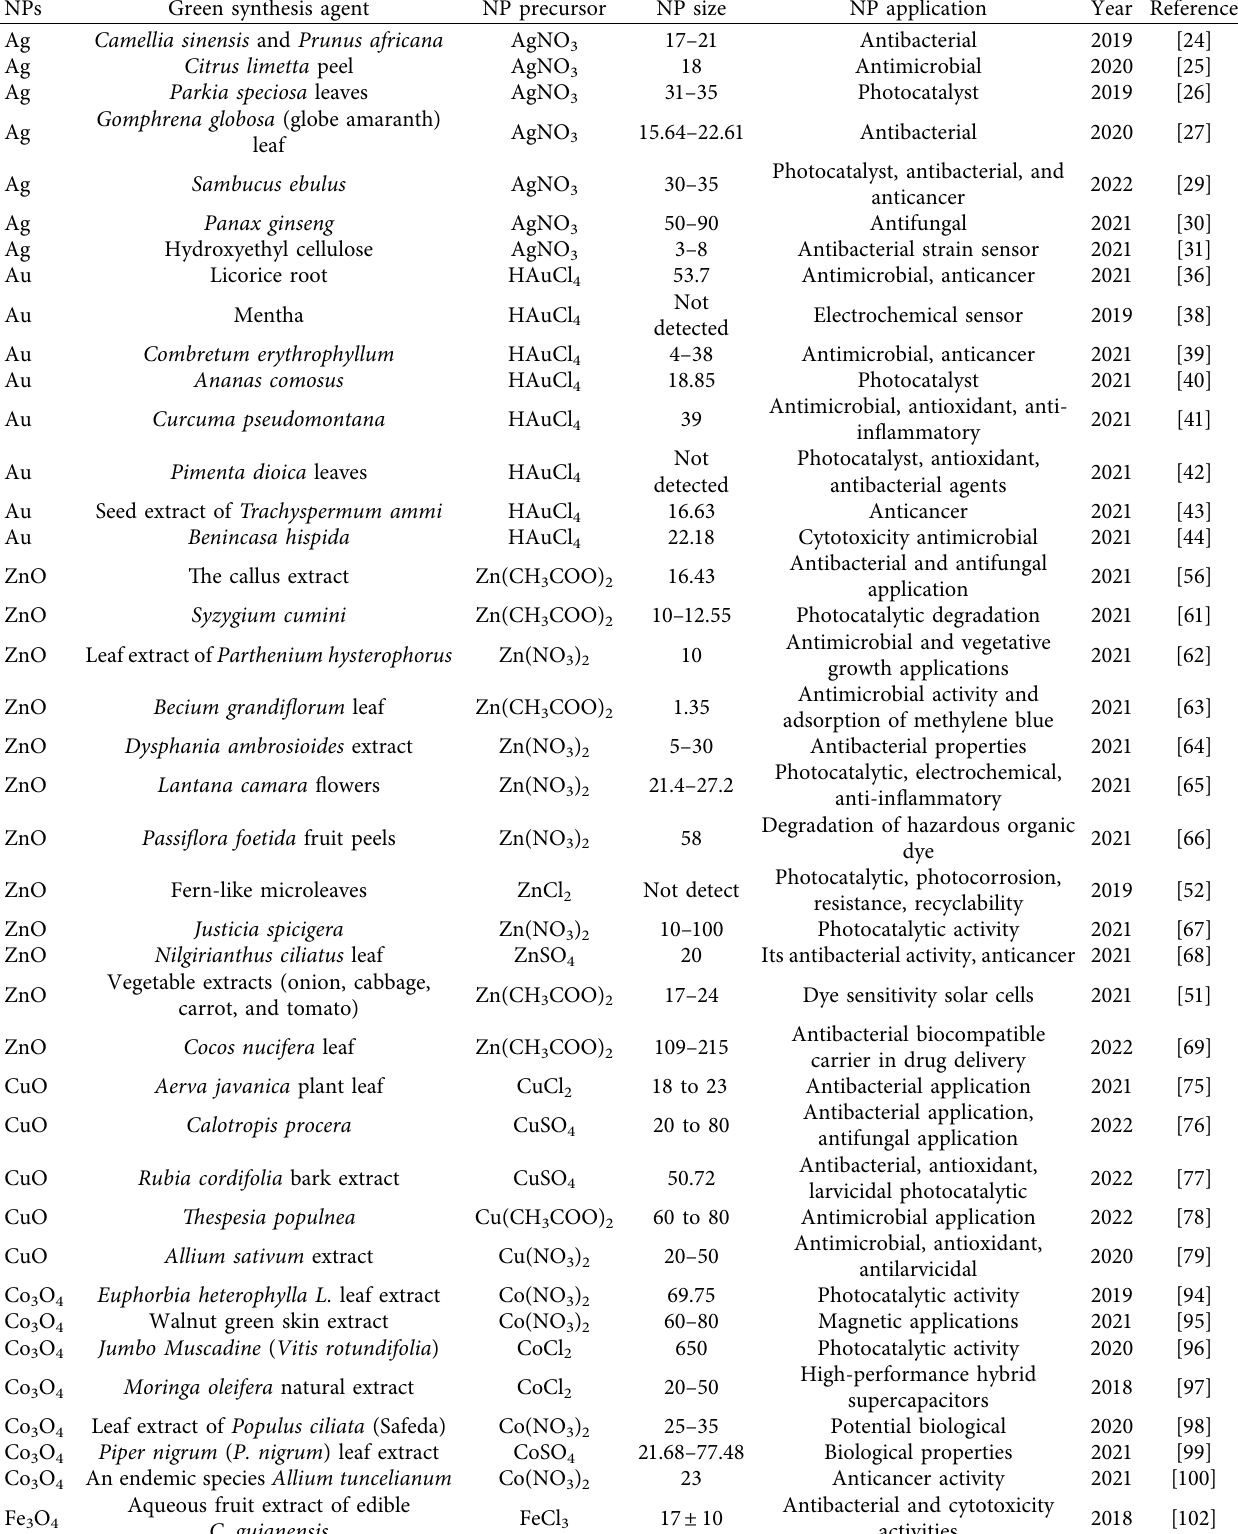
Table 2: Most important characteristics of nanoparticles synthesized using plant